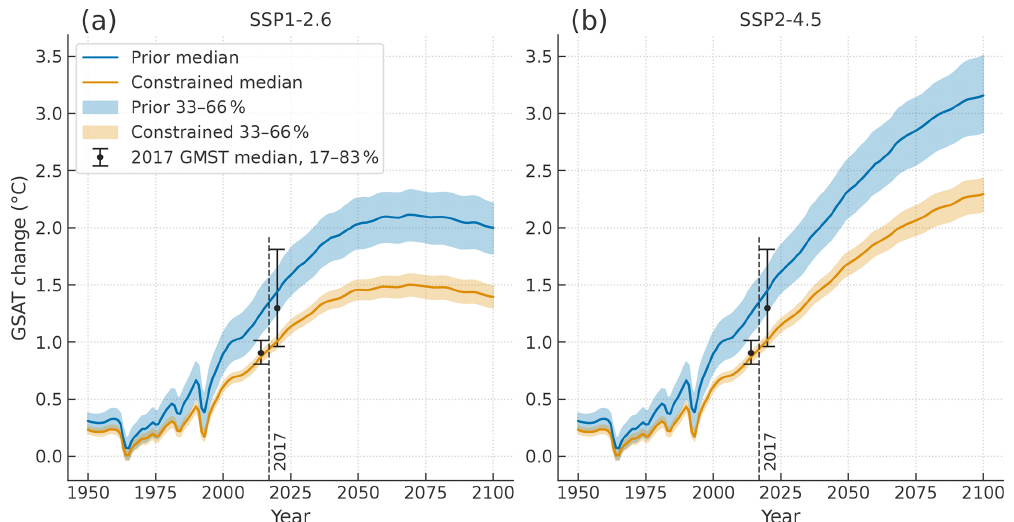
Figure 13. Global mean surface air temperature (GSAT) changes relative to 1850–1900 in SSP1–2.6 (a) and SSP2–4.5 (b) scenarios from Prior and Constrained ensembles. Medians and 33%–66% ranges at each time point are shown by lines and shading. The error bars indicate medians and likely (17%–83%) ranges of global mean surface temperature (GMST, air–ocean blended) changes in 2017. For visual purposes the two error bars are slightly shifted from the reference year of 2017 on the horizontal axis. Table 1. Critical global mean surface air temperature (GSAT) change relative to 1850–1900 in different Shared Socioeconomic Pathway (SSP) scenarios. Warming levels at peak during the 21st century and averaged over the period 2081–2100 (end-21C) are shown for those likely to be limited (66th percentile) and likely to exceed (33rd percentile) from Prior and Constrained ensembles.